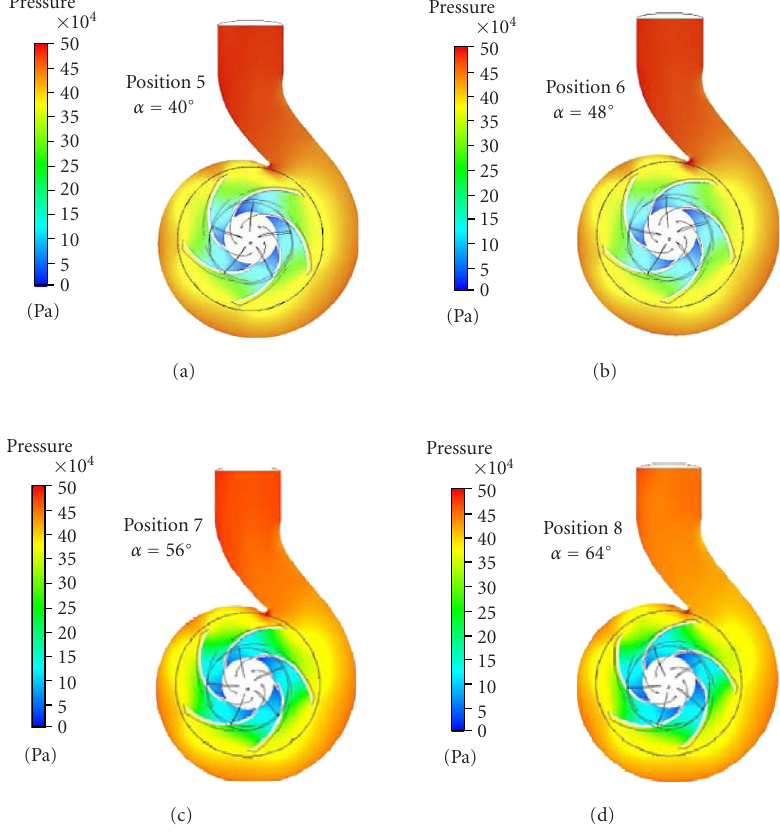
Figure 16: Static pressure field of pump NS32 at the best e ffi ciency point ( Q/Q bep = 1) for di ff erent relative positions of impeller-volute tongue.